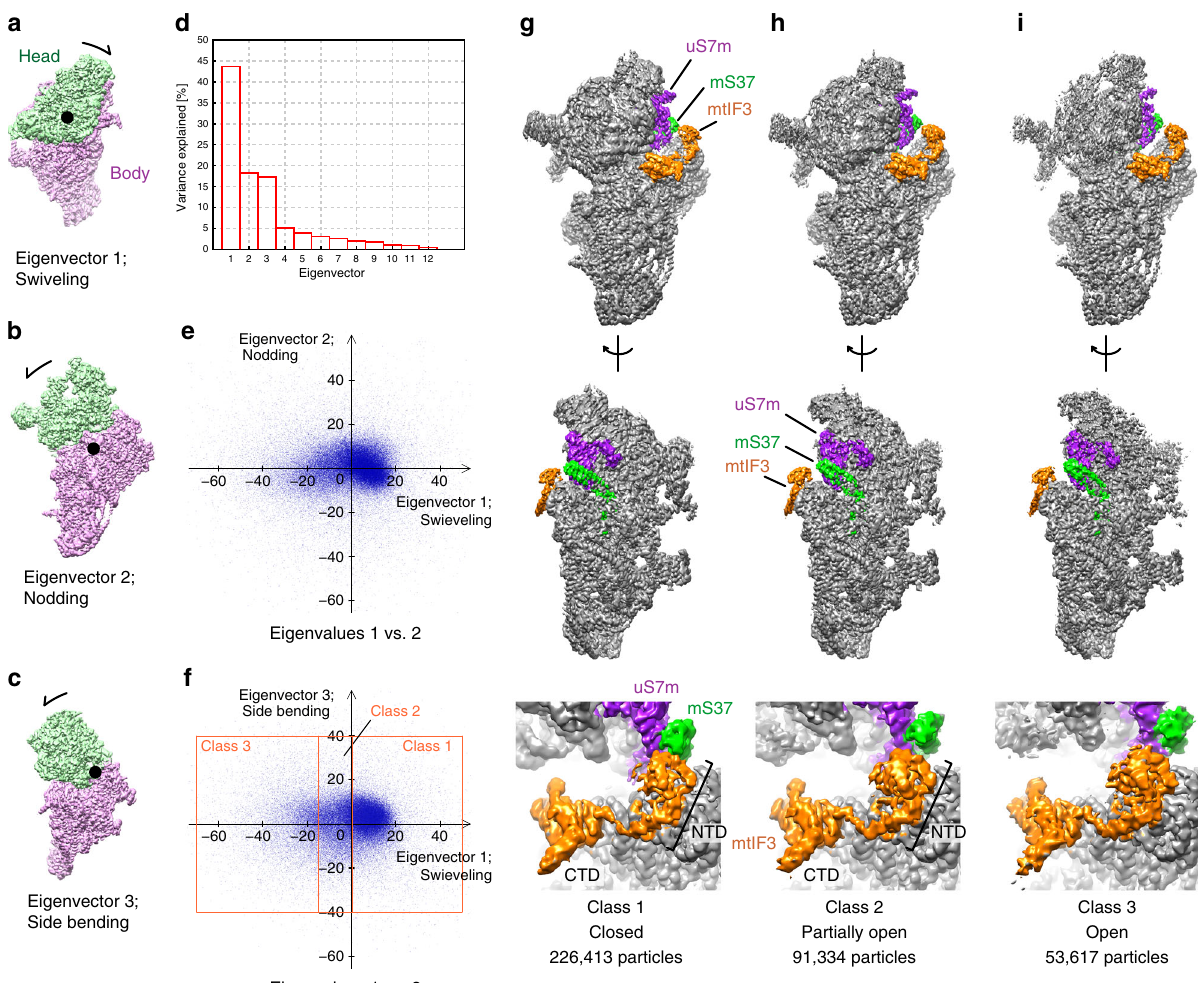
Fig. 4 Principal component analysis of the mtSSU head motion suggests a function for the mitoribosomal protein mS37 in restricting the swiveling. a – c The relative orientation of the head to the body is described by 12 eigenvectors, representing translation and rotation in each particle. The eigenvectors 1, 2, and 3 were found to mainly contribute to the head motion, as indicated. d Histogram of the variances explained by the 12 eigenvectors. e , f The 1st to 3rd eigenvalues of randomly chosen particles represented by dots are plotted against each other, showing non-gaussian distribution for the swiveling motion. The particles are classi fi ed based on the values of eigenvector 1 (rectangles). g , h Comparison between the reconstructions of the classi fi ed particles. The closed conformation (Class 1) exhibits weaker density for the mtIF3-NTD interacting with mS37 and uS7m, compared to the other conformations with higher particle